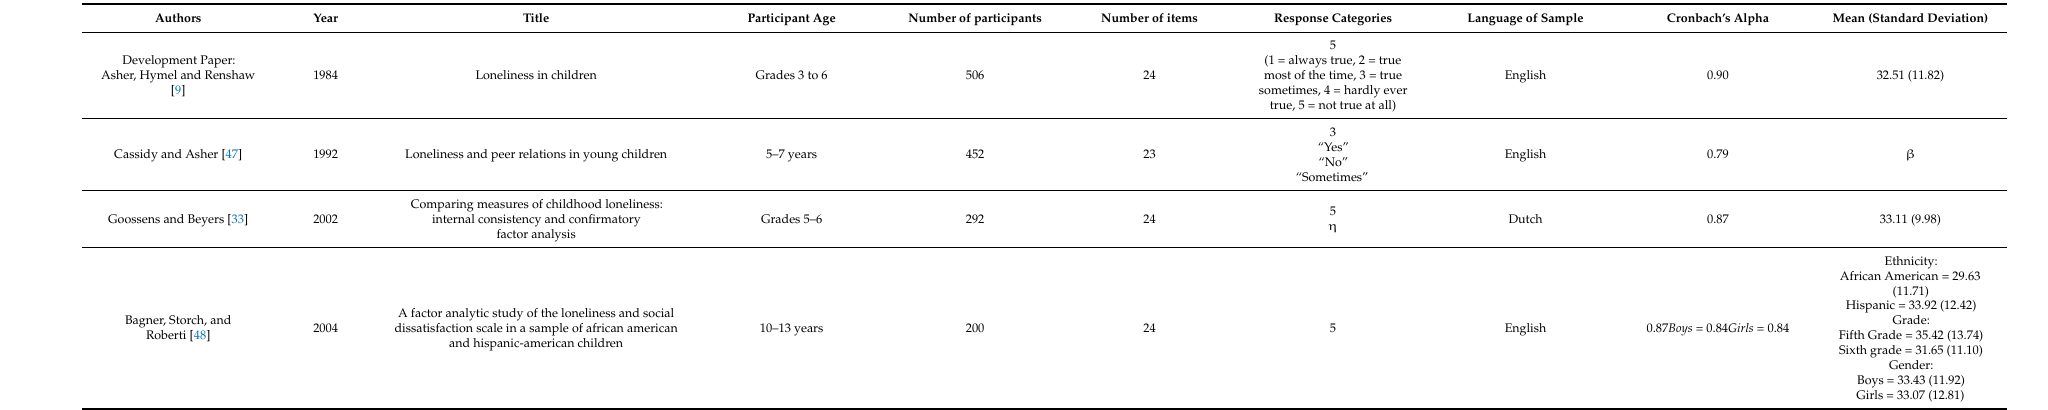
Table 4. Subsequent research papers investigating the reliability and validity of the